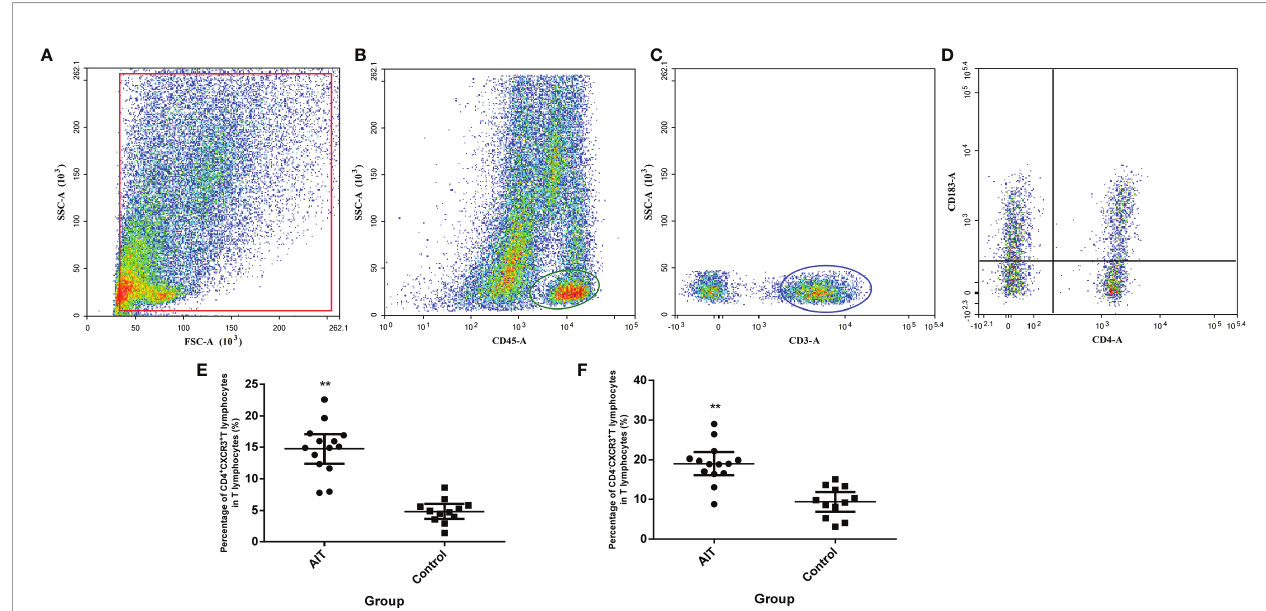
FIGURE 3 | Detection of CXCR3 + T lymphocytes in the follicular microenvironment. Cells were enriched from follicular fl uid, and CD45 + cells were positively selected by MACS cell separation. Separated cells were directly incubated with conjugated anti-CD3, CD4, and CXCR3 antibodies and counted by fl ow cytometry (A) . CD45 + cells were gated (B) and CD3 + cells were gated from CD45 + cells (C) , the expressions of CXCR3 in CD4 + and CD4 - T cells were gated from CD3 + cells (D) . (E, F) The percentage of CD4 + CXCR3 + and CD4 - CXCR3 + T lymphocytes. **P < 0.01 by the Mann-Whitney U